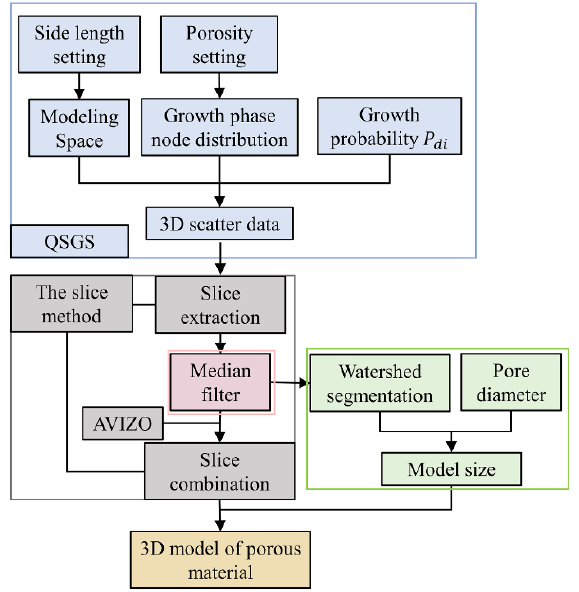
Figure 2. Modeling